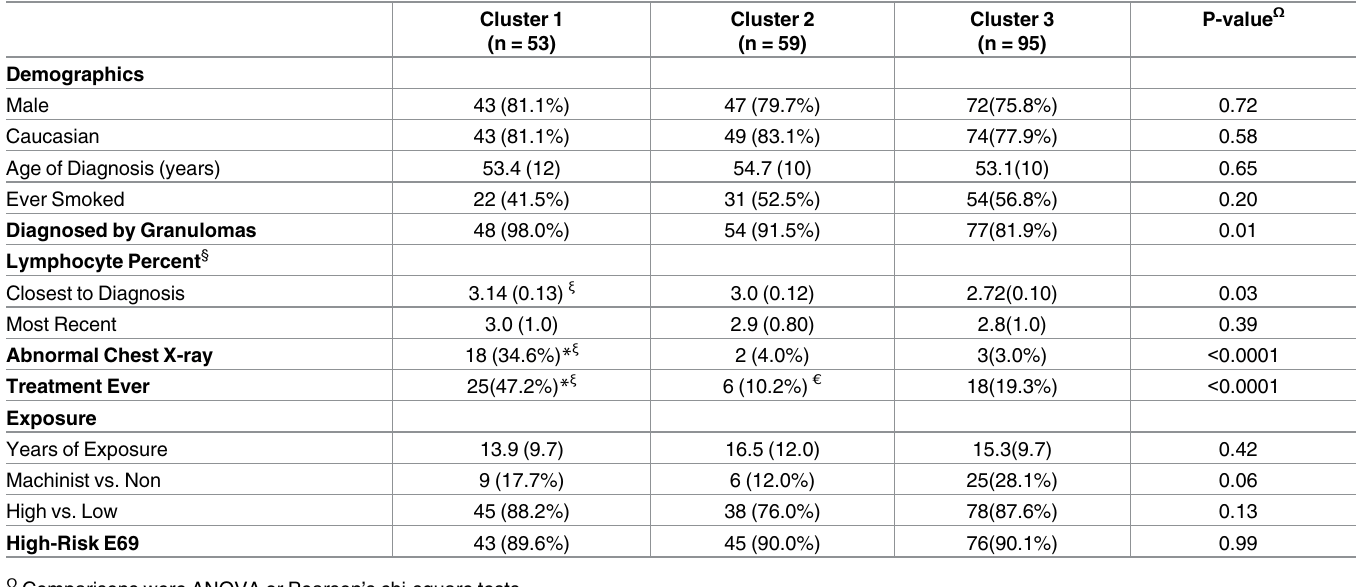
Table 4. Association between patient characteristics and clusters [n(%) or Mean